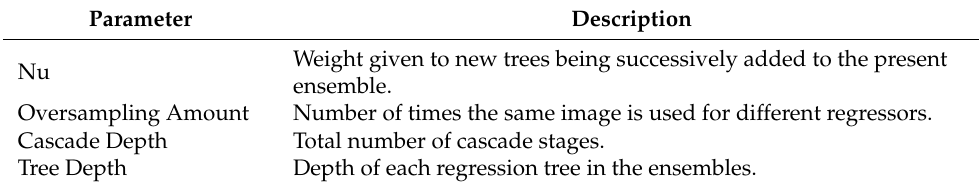
Table 2. Description of the model parameters.